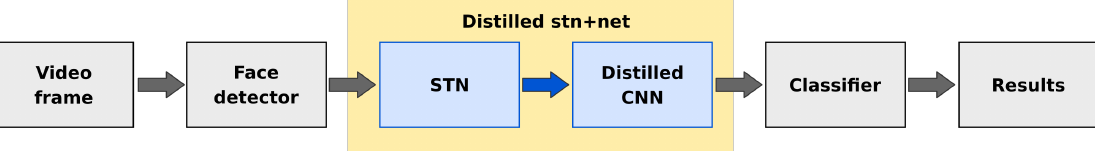
Figure 5. Signal chain of the novel hybrid framework composed by removing from the former the alignment procedure, which is substituted by the Spatial Transformer Network (STN) component in our ‘distilled stn+net’; the end-to-end structure encloses also our feature extractor network, in place of